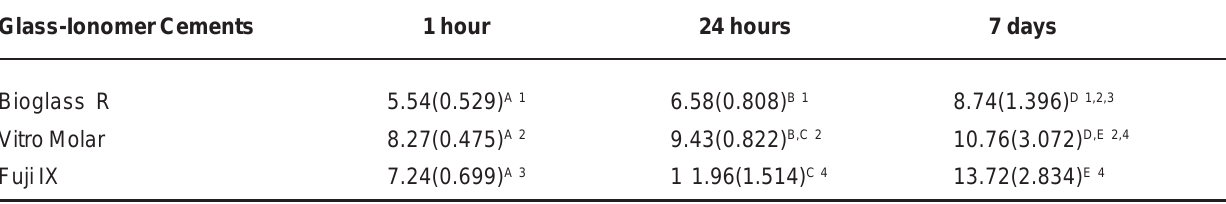
TABLE 3- Mean Diametral Tensile Strength (DTS) of GIC’s in MPa and standard deviations (SD) Glass-Ionomer Cements